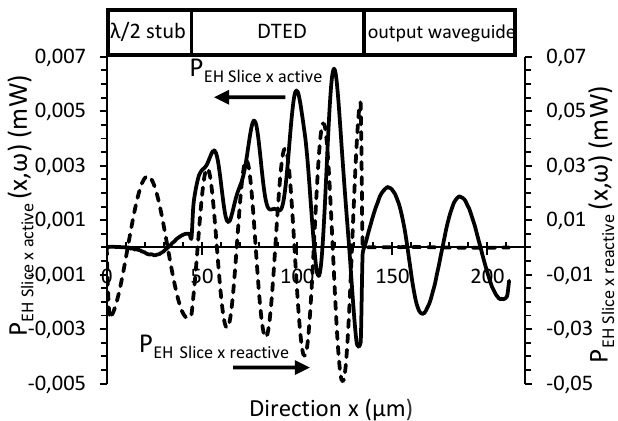
Figure 14: X direction evolution of the active and reactive EM power at the fundamental frequency ω in a transverse slice of the